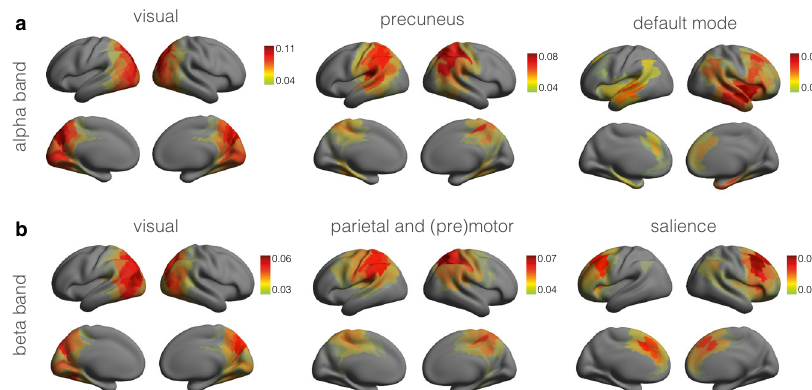
Fig. 4 Non-Gaussian power correlation networks. a Non-Gaussian power correlation networks extracted from spontaneous cortical oscillations in the alpha frequency band. The ordering of the networks is arbitrary. b Non-Gaussian power correlation networks extracted from spontaneous cortical oscillations in the beta frequency band. The networks in both panels were extracted by clustering of the group-level seed-based cokurtosis matrices in the respective frequency bands. Displayed are the cluster centers. For better visibility, the networks were thresholded at their average values.